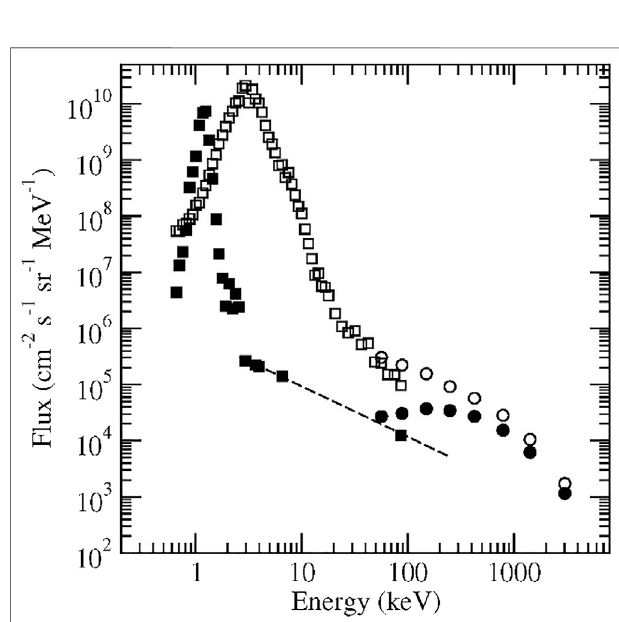
FIGURE 3 | Data from Lario et al. (2019); panels (b) and (f) of their Figure 10. The fi lled symbols are spectra about 30 min prior to the crossing of a shock. The open symbols are about 12 min after the shock crossing. The circles are ACE/EPAM data, and the squares are ACE/SWICS